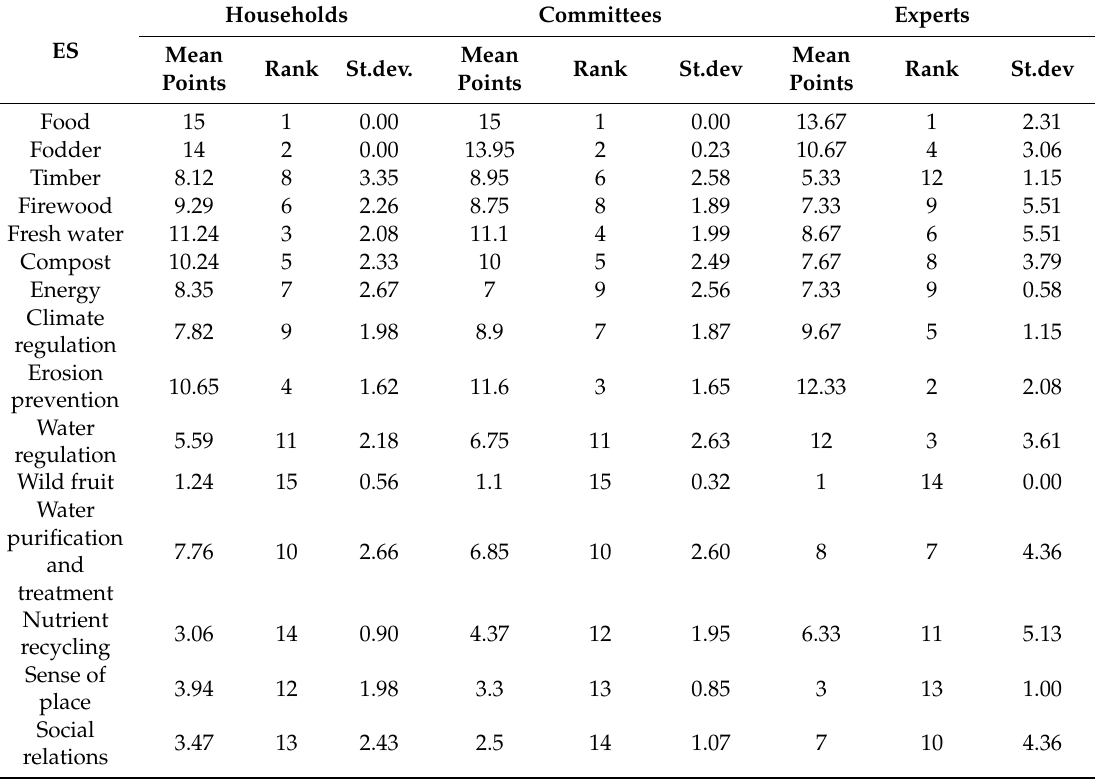
Table 4. Rankings of the most important ES by households, committees and